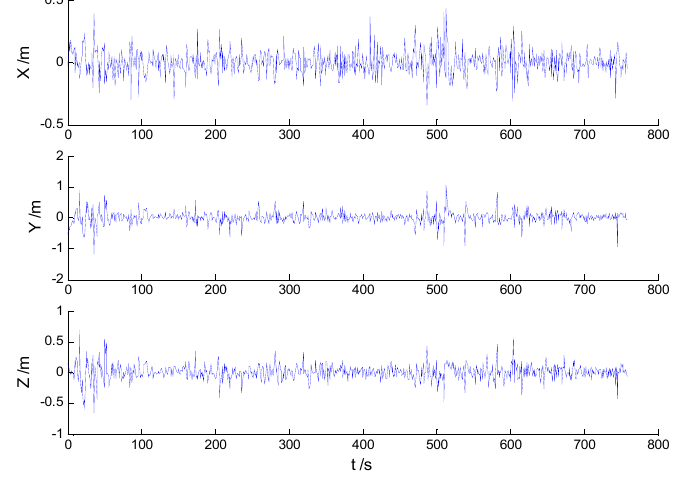
Figure 8. Position errors of the HF algorithm.